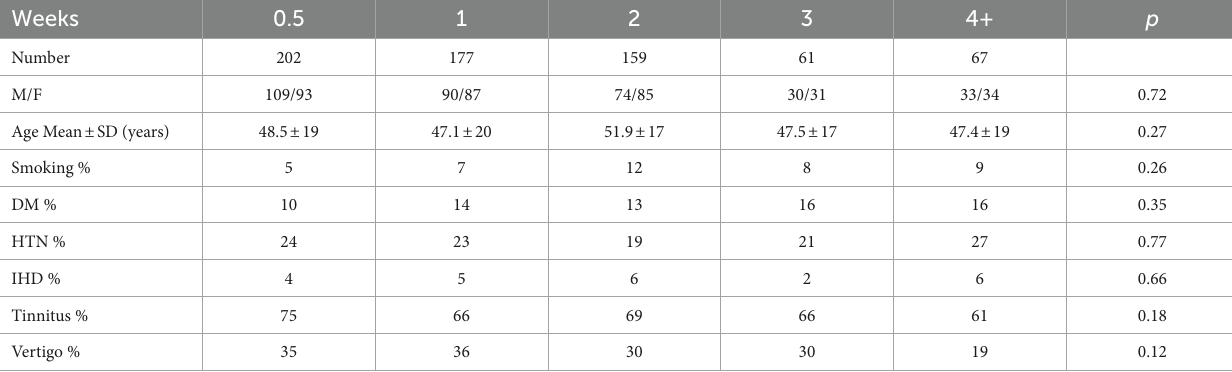
The p -value represents the difference between half, one and 2 weeks vs. three and 4 weeks and over. M/F, male/female; DM, Diabetes Mellitus; HTN, Hypertension; IHD, Ischemic Heart Disease. p -value obtained from Kruskal-Wallis or ANOVA test as appropriate.